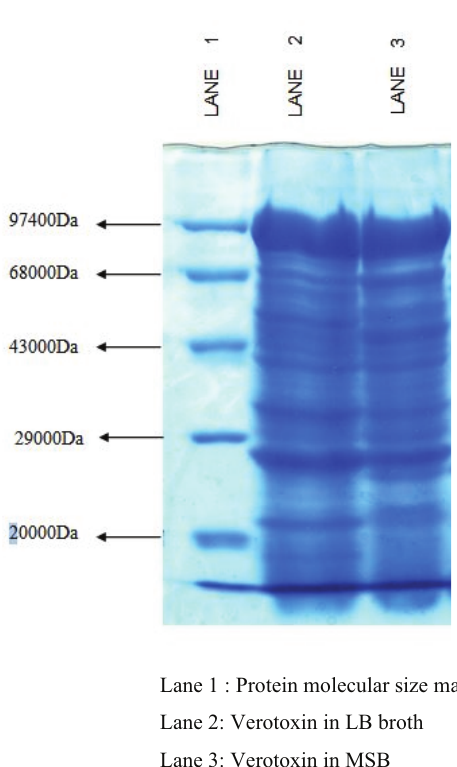
Figure 3 : SDS-PAGE analysis of